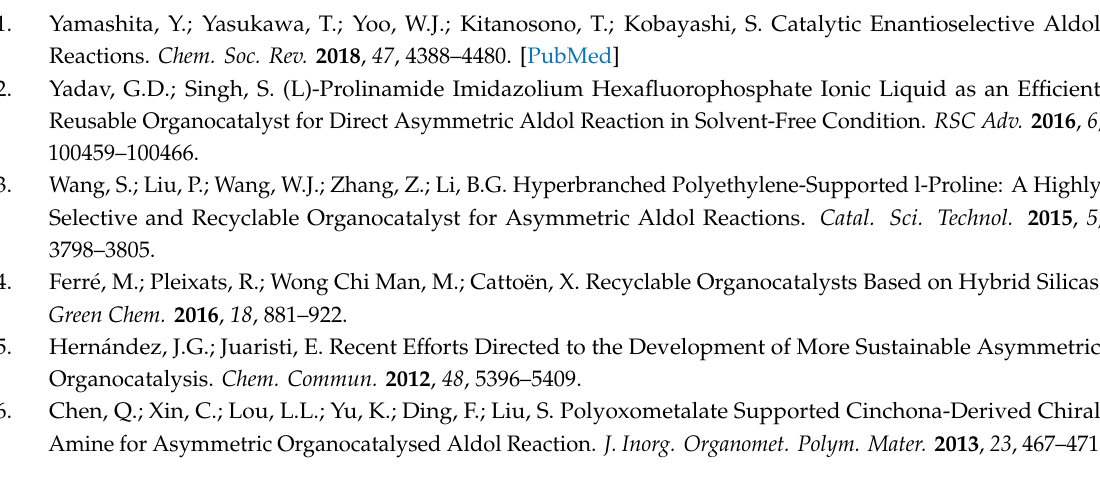
Figure S1: Infrared spectra of (a) MWCNTs, (b) L-proline, and (c) L-proline / MWCNTs., Figure S2. (A) N 2 adsorption and desorption curves of MWCNTs (red trace) and L-proline / MWCNTs (blue trace), (B) the pore size distribution of MWCNTs (black trace) and L-proline / MWCNTs (red trace), Figure S3: SEM of (a) MWCNTs and (b) L-proline / MWCNTs., Figure S4. TGA of (1) MWCNTs, (2) cyclohexane / MWCNTs, (3) pyrrolidine / MWCNTs, (4) quinine / MWCNTs, (5) glycine / MWCNTs, (6) arginine / MWCNTs., Figure S5: Chiral HPLC of product when (a) L-proline / MWCNTs and (b) L-proline applied., Figure S6: Circular dichroism spectra of L-proline / MWCNTs (green) and neat L-proline (red). The solid samples were tested by potassium bromide tablet at room temperature and 999.985 V., Figure S7: HPLC of product without (a) and with (b) filtration treatment., Figure S8: Recycling and reuse of L-proline / MWCNTs catalyst in Mannich reaction., Figure S9: Recycling and reuse of L-proline / MWCNTs catalyst in Michael reactions., Figure S10: Recycling and reuse of L-proline / MWCNTs catalyst in α -oxyamination reaction., Figure S11: Recycling and reuse of L-proline / MWCNTs catalyst in Knoevenagel condensation., Table S1: Elemental analysis of L-proline /